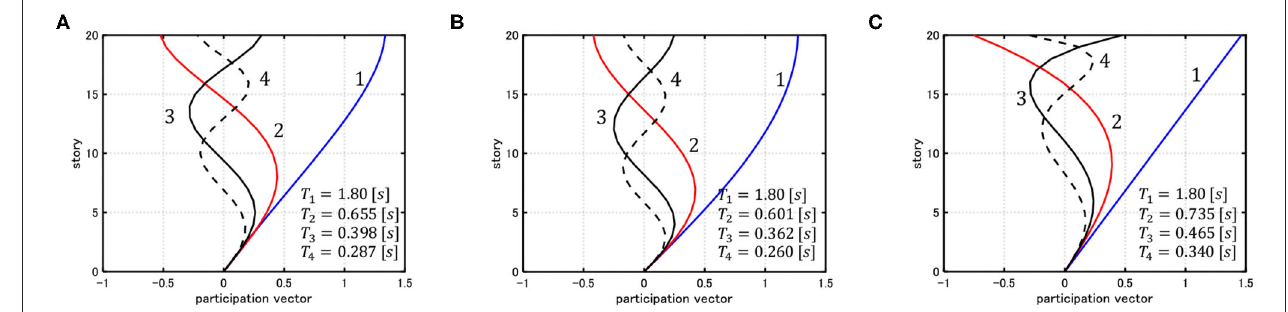
FIGURE 6 | First three eigenmodes multiplied by participation factors for the 20-story building model. (A) Model 1, (B) Model 2, (C) Model